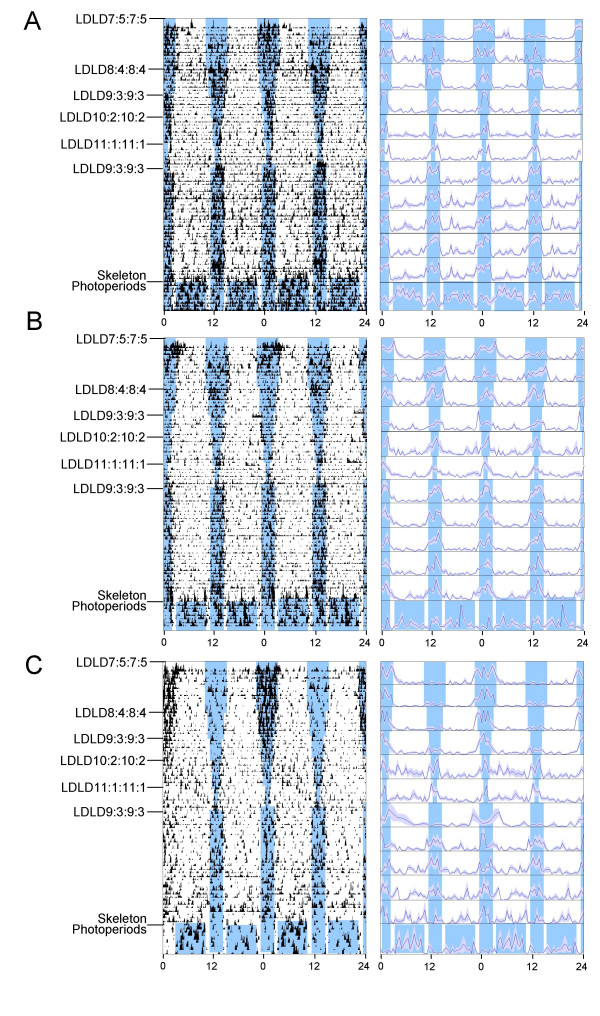
Representative double-plotted actograms (left) and 6-day average activity profiles (± SEM) (right) of hamsters lacking running wheels and monitored by motion detectors. Conventions as in Figure 1. Rhythms of animals in (A) and (B) split early in the experiment but did not remain split under skeleton photoperiods. The hamster in (C) expressed a split rhythm only in LDLD9:3:9:3.